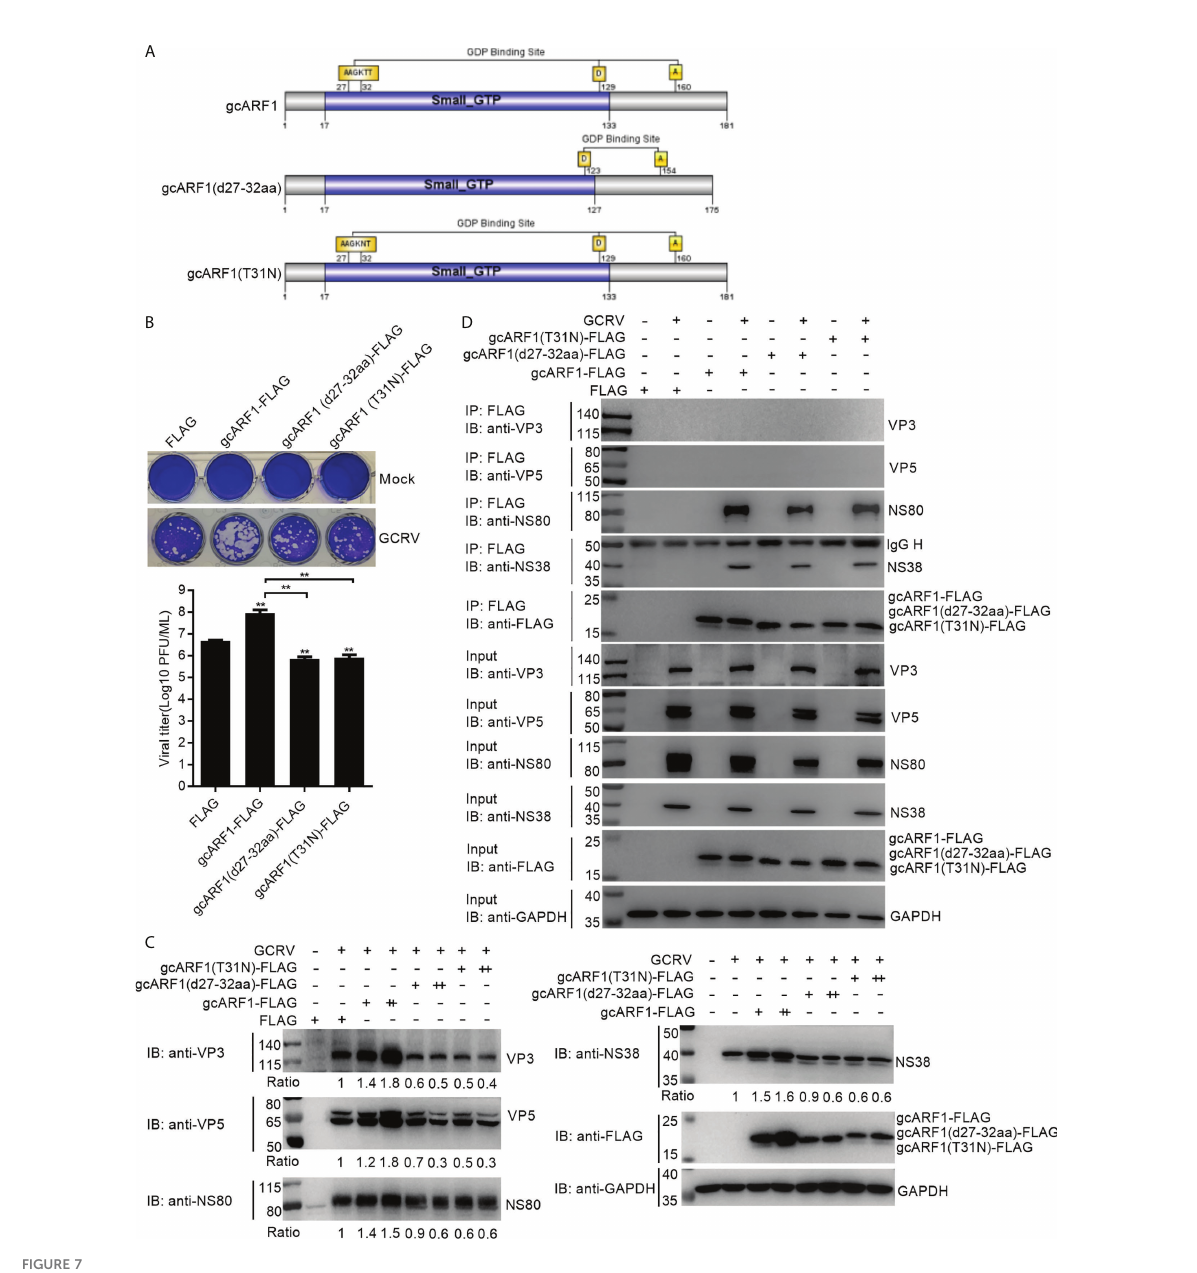
FIGURE 7 The 27 AAGKTT 32 motif and T 31 residue are required for the function of gcARF1 in promoting GCRV replication and infection. (A) Schematic representation of the gcARF1 and its mutants. (B) Crystal violet staining and determination of GCRV titers for overexpression of gcARF1 mutants including gcARF1(d27-32aa) and gcARF1(T31N) in CIK cells that were infected with GCRV at an MOI of 1 for 24 h. The asterisk above the error bars indicated statistical signi fi cance using the group transfected with FLAG as the control group. The asterisk above the bracket indicated statistical signi fi cance between the two groups connected by the bracket. (C) IB analysis of VP3, VP5, NS80 and NS38 proteins regulated by overexpression of gcARF1 or gcARF1 mutants including gcARF1(d27-32aa) and gcARF1(T31N) in CIK cells infected with GCRV. CIK cells seeded overnight in 12-well or 6-well plates were transiently transfected with indicated plasmids. After 24 h later, the cells were infected with the GCRV at an MOI of 1 or left untreated. The supernatants in 12-well plates were collected at 24 hpi for viral titer assays, and the cells were fi xed and stained with crystal violet (B) . The cells in 6-well plates were collected at 24 hpi for protein extraction (C) . +: 500 ng, ++: 1000 ng. The expression ratios for viral proteins were quanti fi ed by Quantity One. (D) The interactions between gcARF1, gcARF1(d27-32aa) or gcARF1(T31N) and viral proteins. CIK cells seeded in 10-cm 2 dishes were transfected with the indicated plasmids. After 24 h later, the cells were infected with or without the GCRV at an MOI of 1. Then the cells were harvested and lysed at 24 hpi. Co-IP was performed with anti-FLAG-conjugated agarose beads. The cell lysates and bound proteins were analyzed by immunoblotting with the indicated